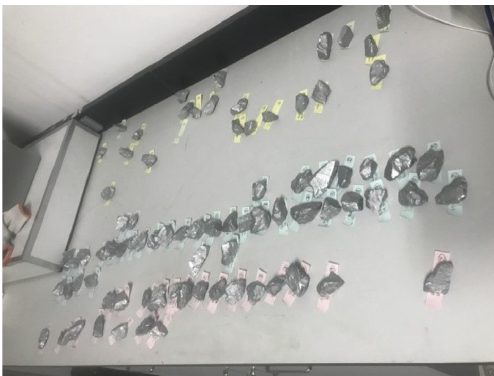
Figure 2: The collective largeness of the rock material shape factor.